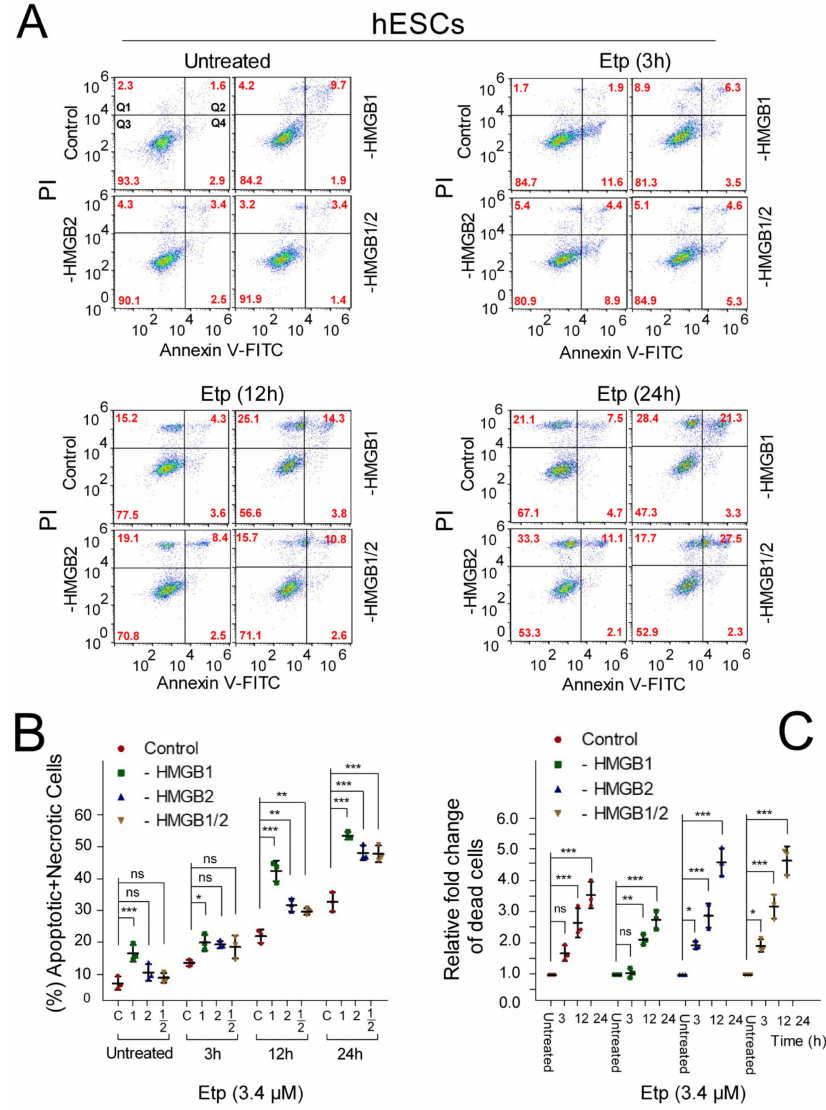
Figure 4. Distinct impact of HMGB KD on apoptosis of hESCs treated with etoposide. ( A ) Representative dot plots showing Annexin V / propidium iodide (PI) binding assays in etoposide-treated hESCs upon HMGB1 and / or HMGB2 KD, as analyzed by flow cytometry. Q1 (Annexin V − / PI + ), dead cells; Q2 (Annexin V +/ PI + ), late apoptotic and necrotic cells; Q3 (Annexin V − / PI − ), viable cells; Q4 (Annexin V +/ PI − ), early apoptotic cells. Values in red represent percentages of cells in Q1–Q4. ( B ) Percentage of apoptotic + necrotic cells in hESCs from ( A ). ( C ) Relative fold change of total cell death among populations of control or HMGB KD hESCs compared to untreated cells. Error bars represent the mean and SD of three independent experiments. Data were analyzed using either Bonferroni post hoc test for the (percentage of apoptotic + necrotic cells) or Tukey’s multiple comparison test for analysis of the relative fold change of dead cells ( p > 0.05 = not significant, ns; * p < 0.05; ** p < 0.01; *** p < 0.001). “C”, cells transfected with empty vector; “HMGB1”, cells upon HMGB1 knockdown; “HMGB2”, cells upon HMGB2 knockdown; “HMGB1 / 2”, cells upon HMGB1 and HMGB2 knockdown. “1”, cells upon HMGB1 knockdown; “2”, cells upon HMGB2 knockdown; “1 / 2”, cells upon HMGB1 and HMGB2